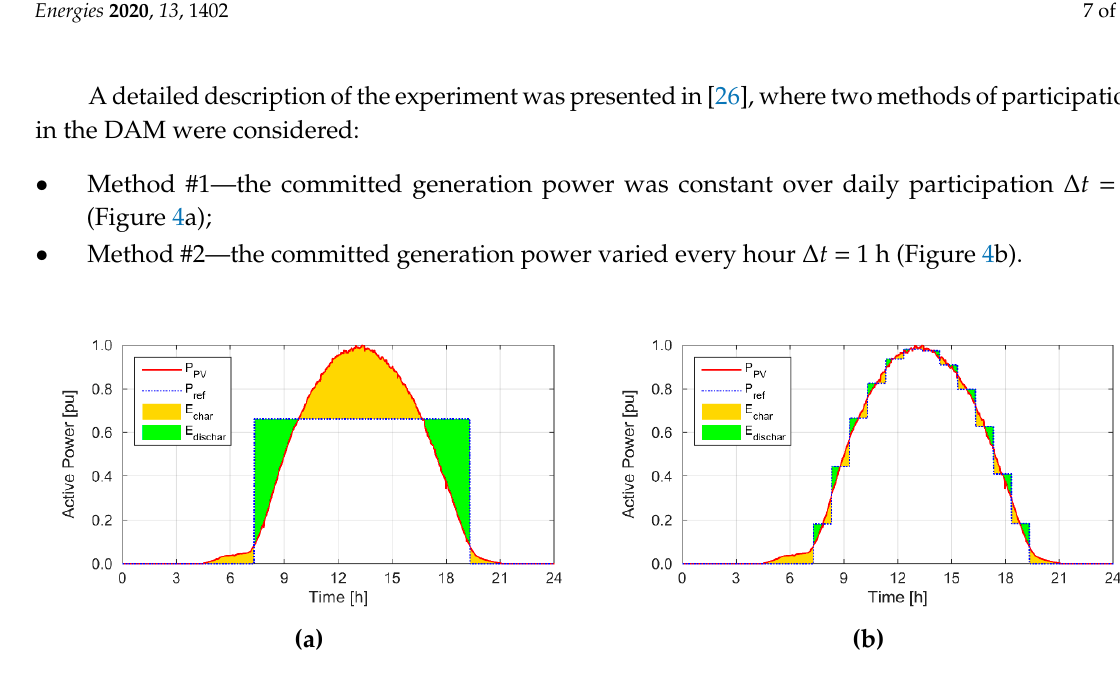
Figure 3. Test power system topology, T – power transformer 15/0.4 kV/kV, P PVmeas —measured power output of PV system, P ref – set power level for PV system, based on the declarations submitted to the day-ahead market (DAM) through balancing group and weather forecasts.